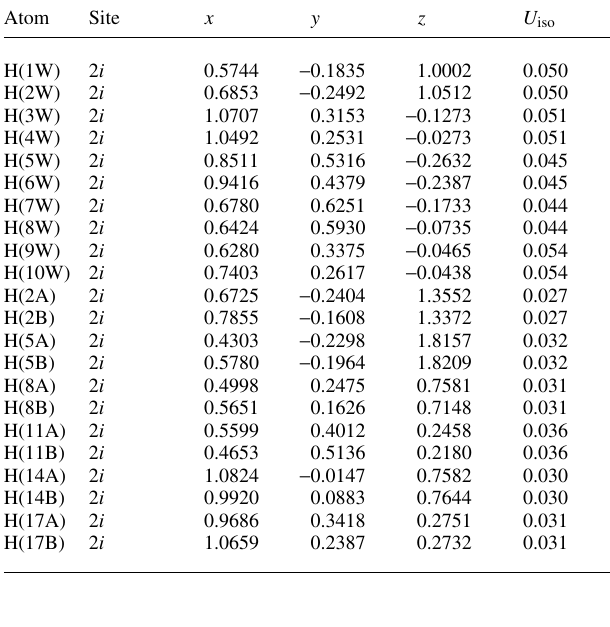
Table 2. Atomic coordinates and displacement parameters (in Å 2 ) .